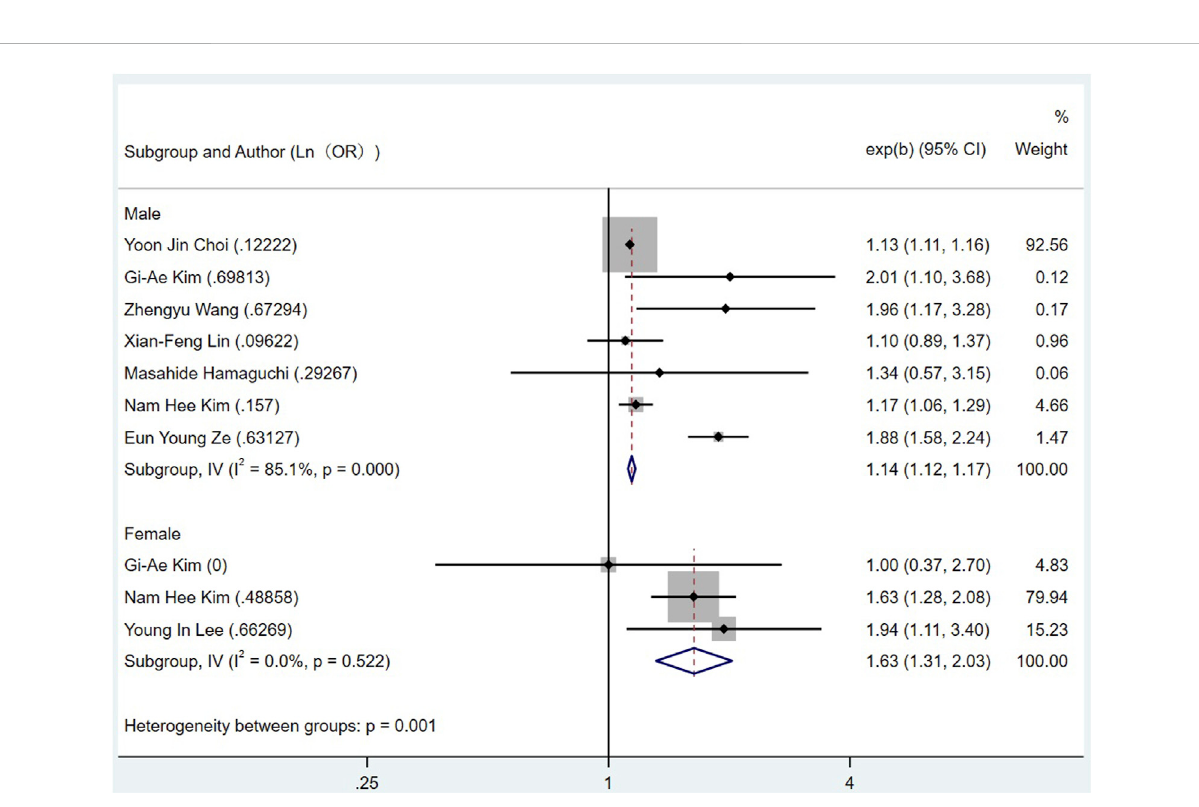
Subgroup analysis for the risk of CRC in patients with NAFLD in different